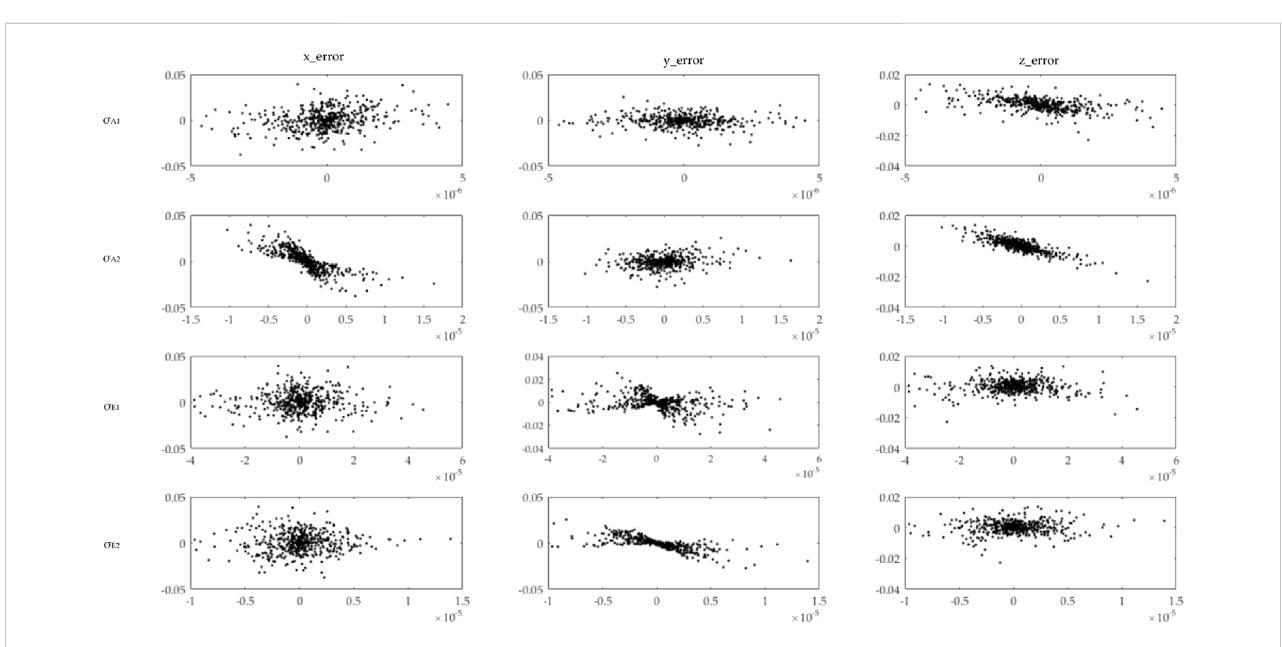
Error in fl uence of the angle measurement error on coordinate